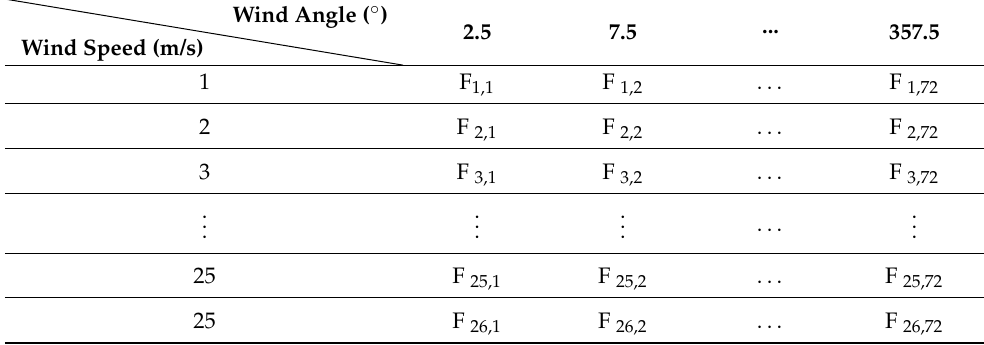
Table 1. Layout of the wind field probability matrix. Wind Angle ( ◦ ) Wind Speed (m/s) <1